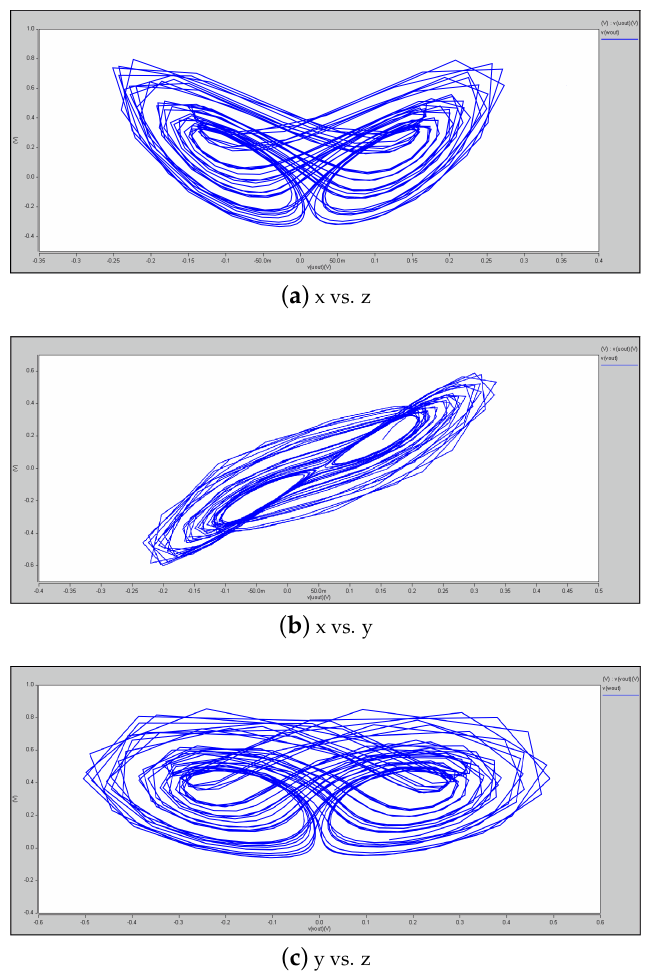
Figure 12. Phase portraits of the CMOS OTA-based fractional-order chaotic system given in (10) and using CMOS technology of 180